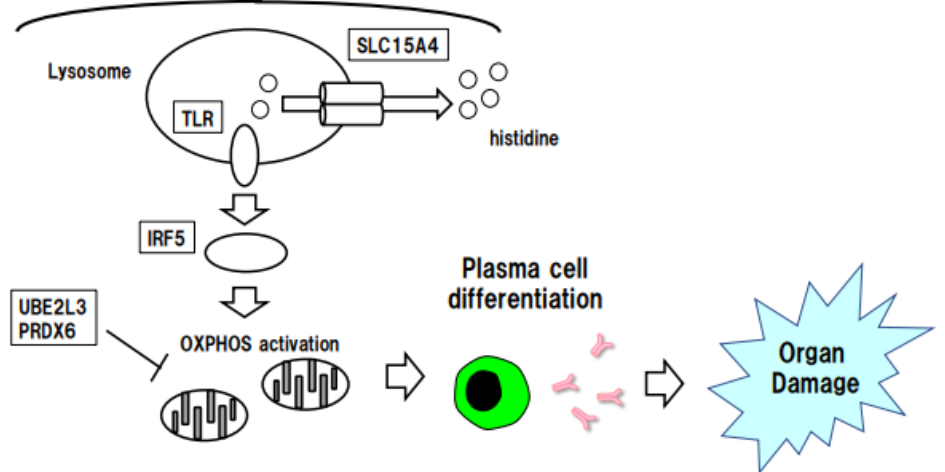
Figure 3. Possible mechanism of increased risk for SLE. Increased expression of SLC15A4 alters the intracellular level of histidine, enhances innate immune signaling by TLRs, enhances OXPHOS, and promotes B-cell differentiation, which is associated with organ damage.